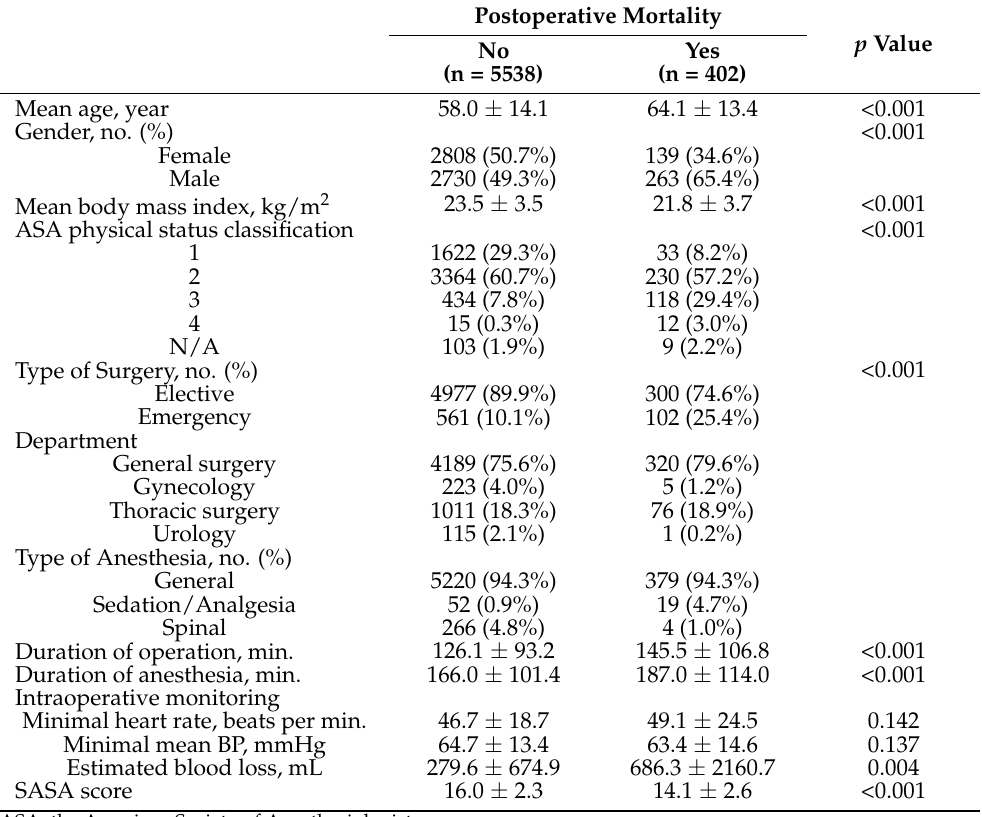
Table 1. Patient characteristics stratified by postoperative mortality in